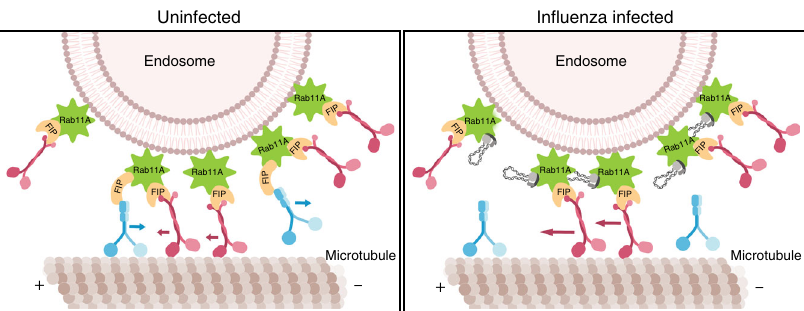
Fig. 8 Schematic of altered Rab11A movement during in fl uenza viral infection. Based on the data presented in this study, we propose that in fl uenza vRNP will displace dynein motors on Rab11A-containing vesicles to alter movement along